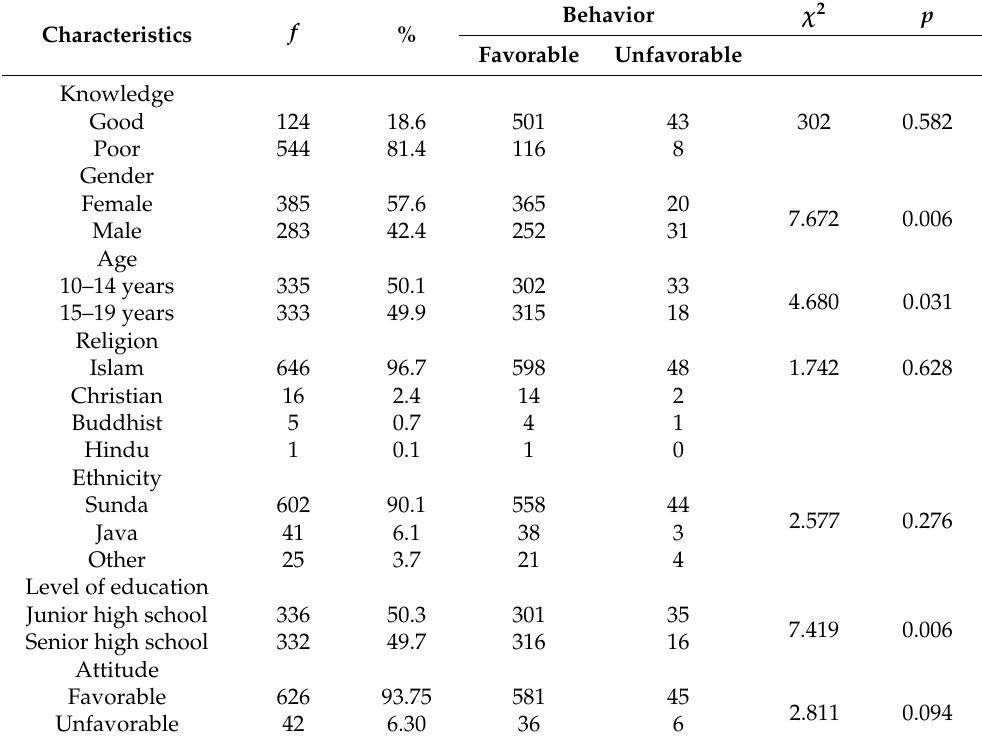
Table 1. The respondents’ characteristics and the bivariate analysis of adolescent reproductive health in Bandung Regency ( n = 668).